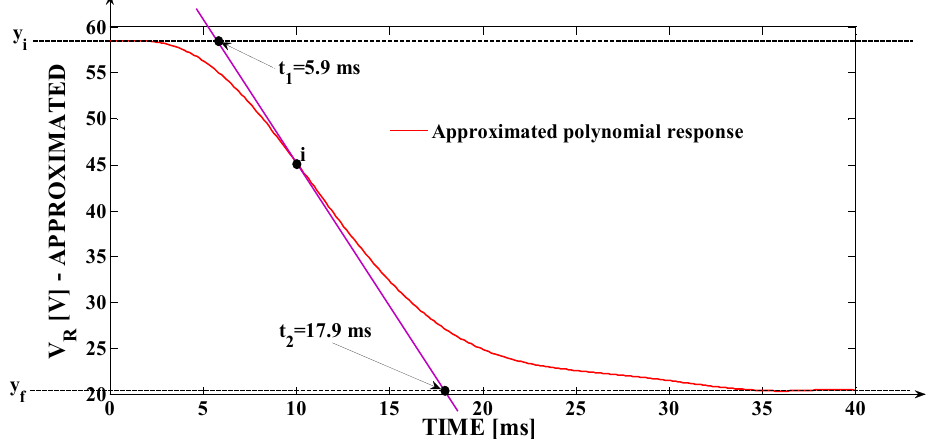
Figure 4. Graphical application of the tangent method using the approximating polynomial model.